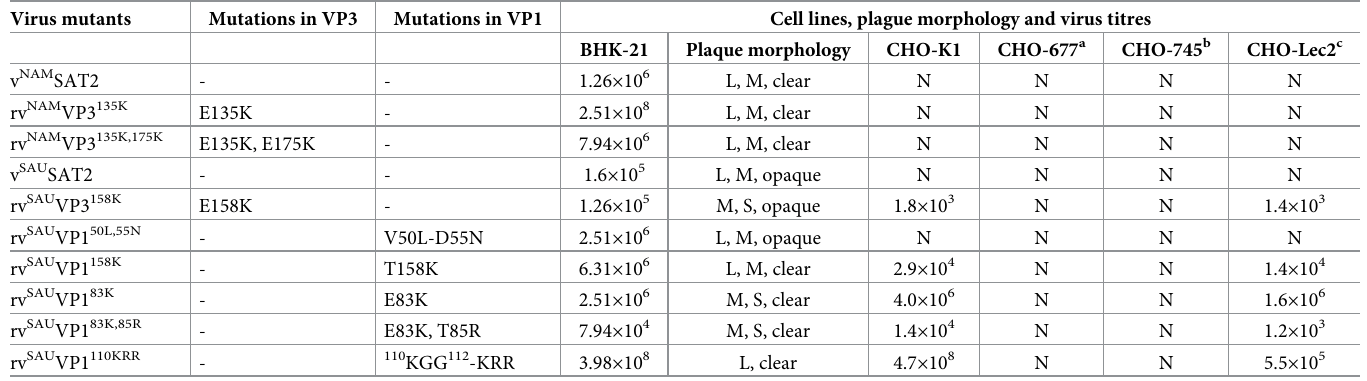
Table 3. Titres (PFU/ml) of inter-serotype or intra-serotype FMDV chimera viruses with positive charged residue substitutions in the VP1 or VP3 capsid proteins. Plaque morphology on BHK-21 cells are indicated. Virus mutants Mutations in VP3 Mutations in VP1 Cell lines, plague morphology and virus titres BHK-21 Plaque morphology